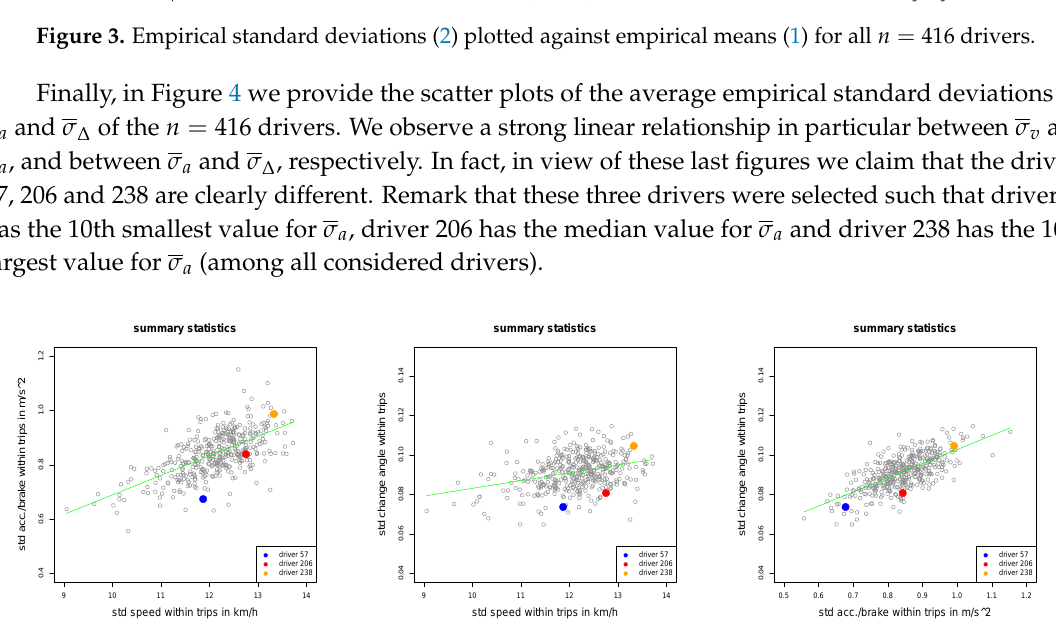
Figure 4. Summary statistics σ v , σ a and σ ∆ of all n = 416